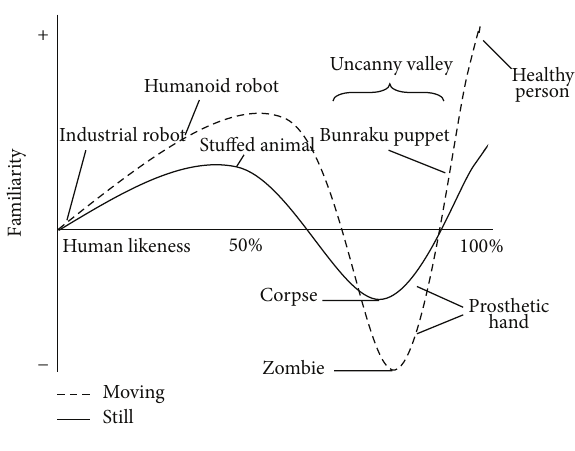
Figure 1: The uncanny valley.